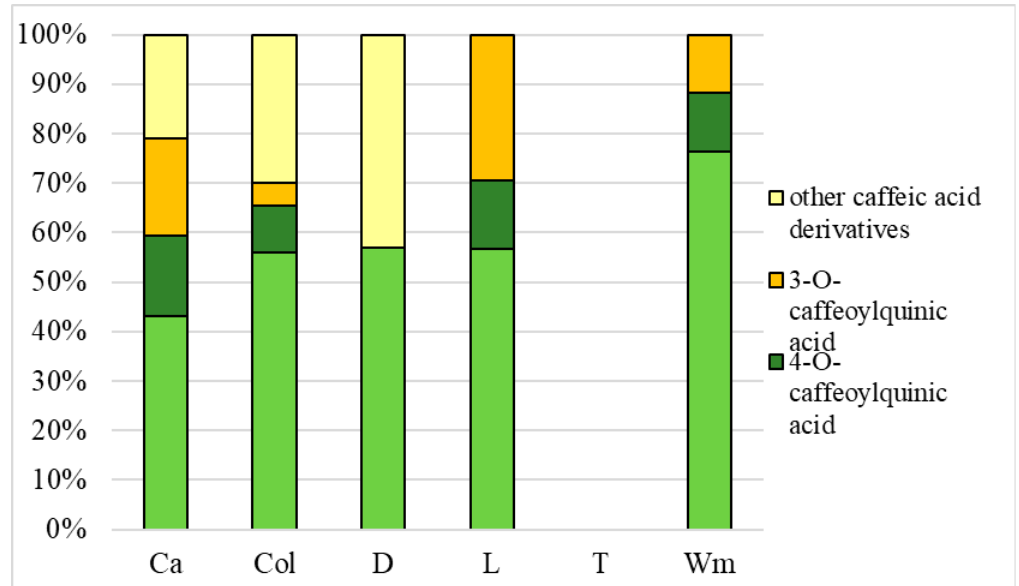
Figure 3. Percentage concentration of caffeic acid derivatives in water extracts. Ca—caraway; Col—Coltsfoot;